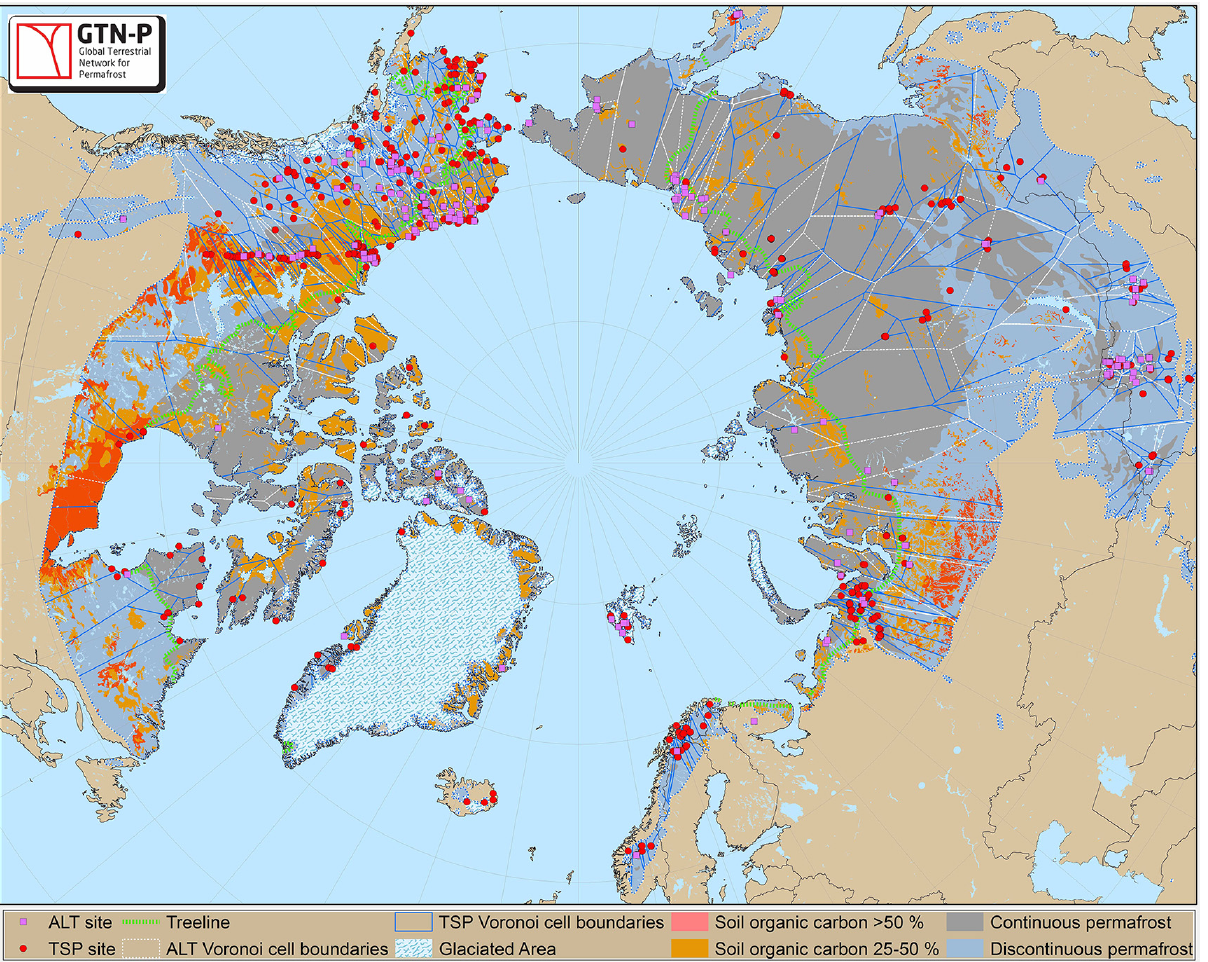
Figure 8. Boundaries of the TSP and ALT Voronoi cells indicate areas with the highest potential of reducing the level of heterogeneity of the site distribution in the Arctic for boreholes and active layer grids, respectively. The map also shows the spatial distribution of permafrost organic carbon content (Hugelius et al., 2013), the treeline (Brown et al., 1998), and the distribution of continuous and discontinuous (including sporadic permafrost and isolated patches) permafrost as well as glaciated areas and water bodies. Where lines intersect with high soil organic carbon content and the transitional zone from continuous to discontinuous permafrost, new permafrost research sites would provide the most important and timely data within the context of recent climate